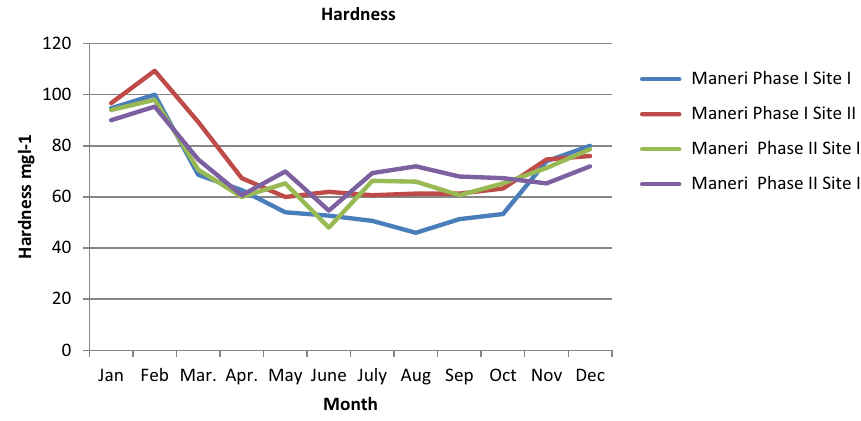
Fig. 8 Monthly recorded Total Hardness (mg l −1 ) of Maneri Phase I and II -site I& II of Bhagirathi river in the year